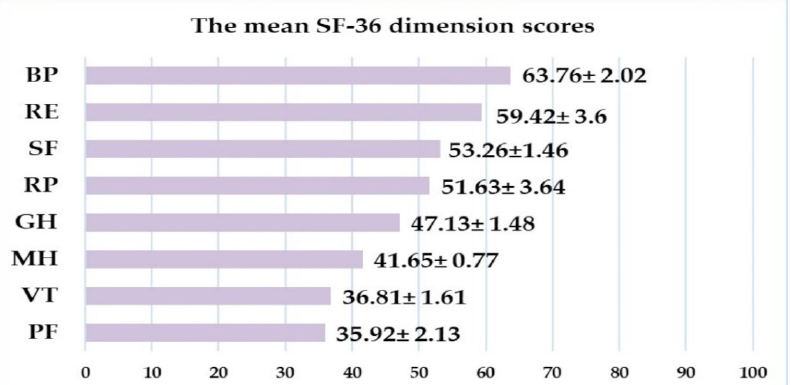
Figure 3. The mean scores for the SF-36 dimensions . PF, physical functioning; VT, vitality; MH, mental health; GH, general health; RP, role-physical; SF, social functioning; RE, role-emotional; BP, bodily pain. Range 0–100, higher scores indicate more favorable views of own health. Table 4. SF-6Dv2 utility scores according to the patients’ characteristics Characteristics